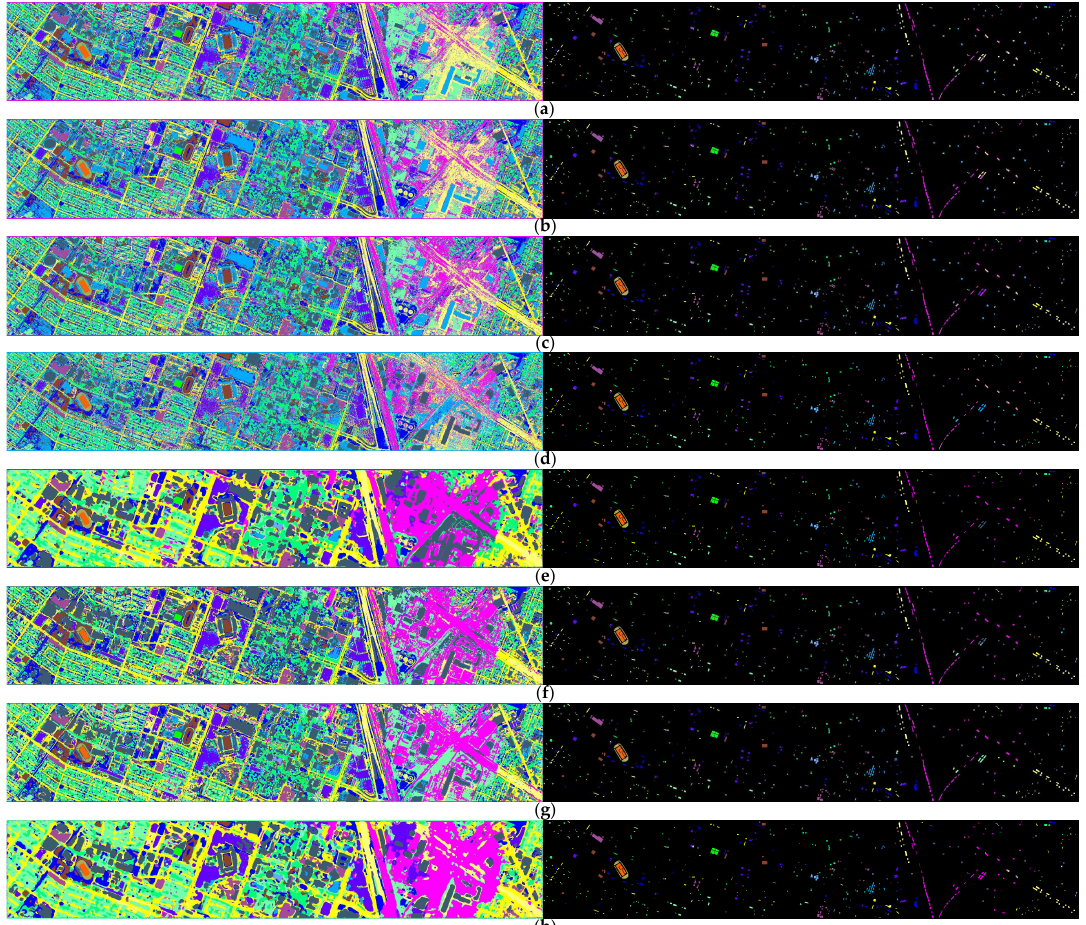
Figure 11. Classification maps for the Houston dataset obtained by SVM classification after